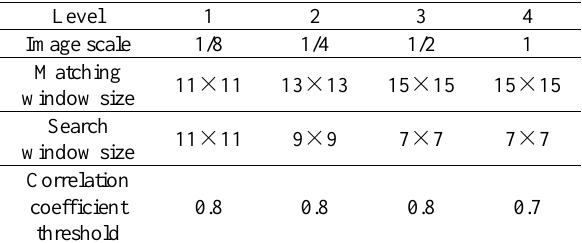
Table 1.Selected parameters for hierarchical image